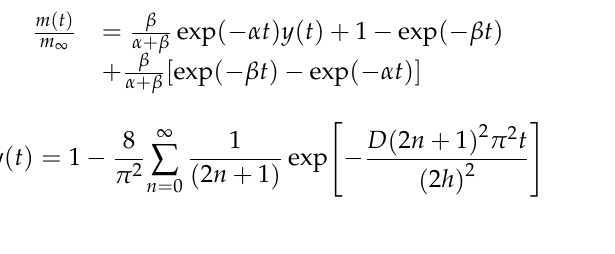
Table 1. The test conditions. Test Humidity Temperature 53% 82% 100% In Deionized Water √ √ √ √ 40 ◦ C 60 ◦ C 80 ◦ C